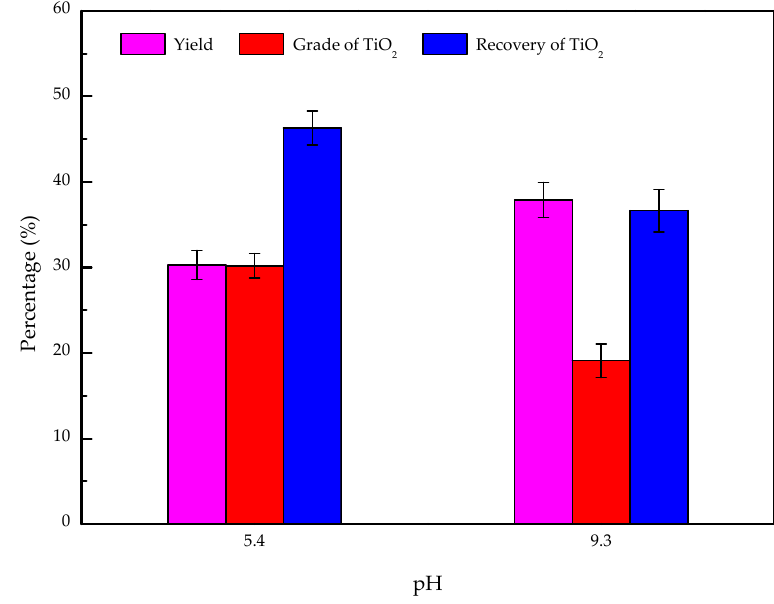
Figure 12. The yields, TiO 2 grades, and recoveries of the concentrates from artificially mixed mineral flotation at different pH